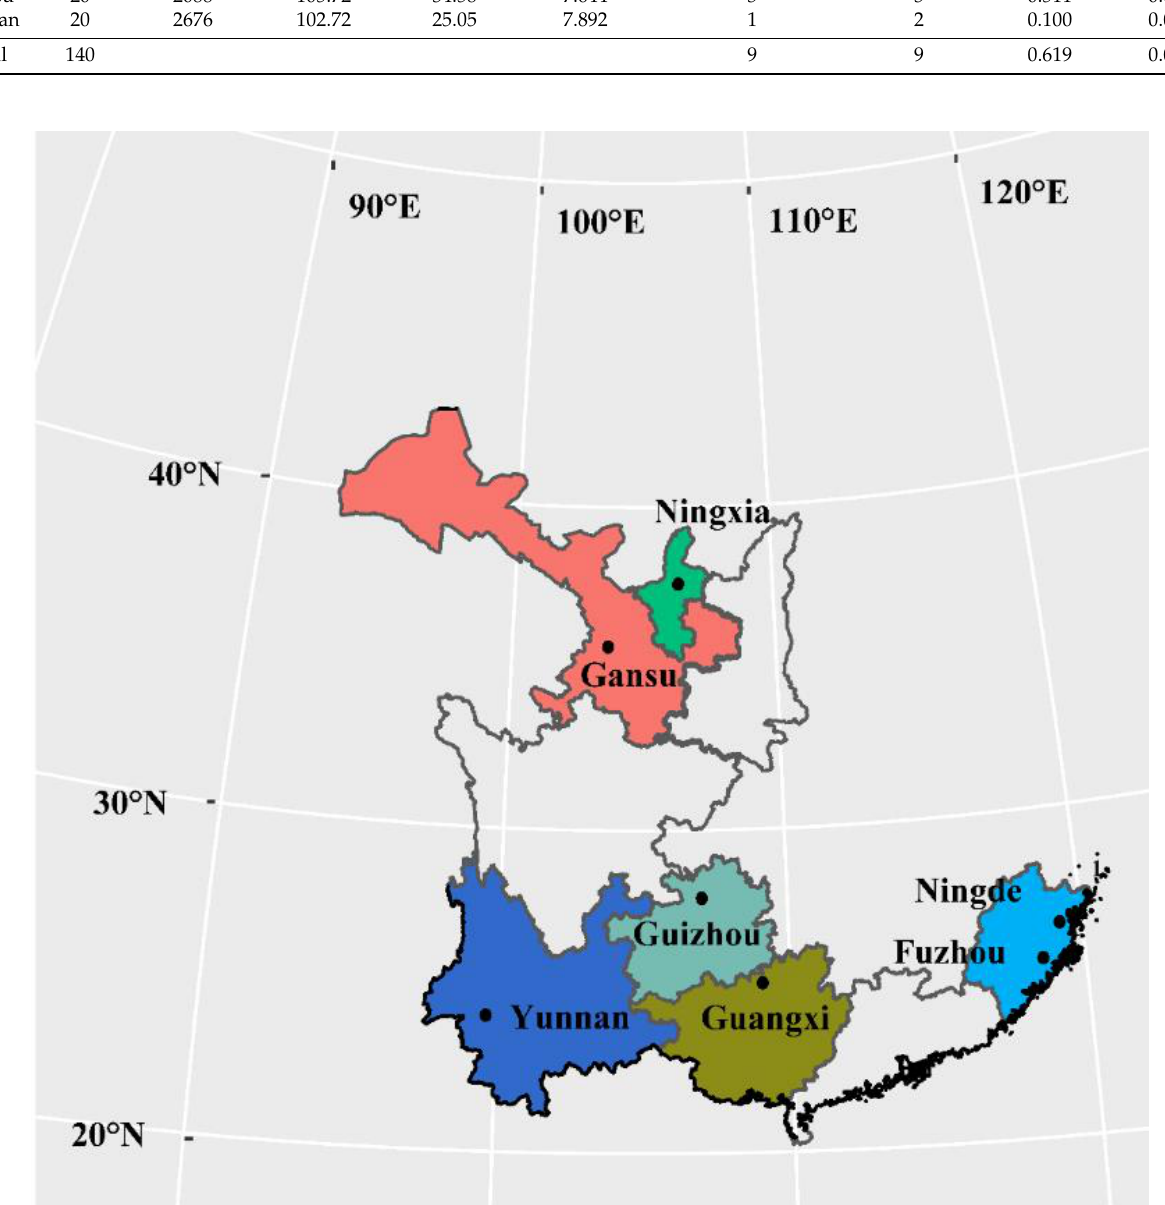
Figure 1. Map showing the geographical locations of the seven Phytophthora infestans populations sampled for this study.